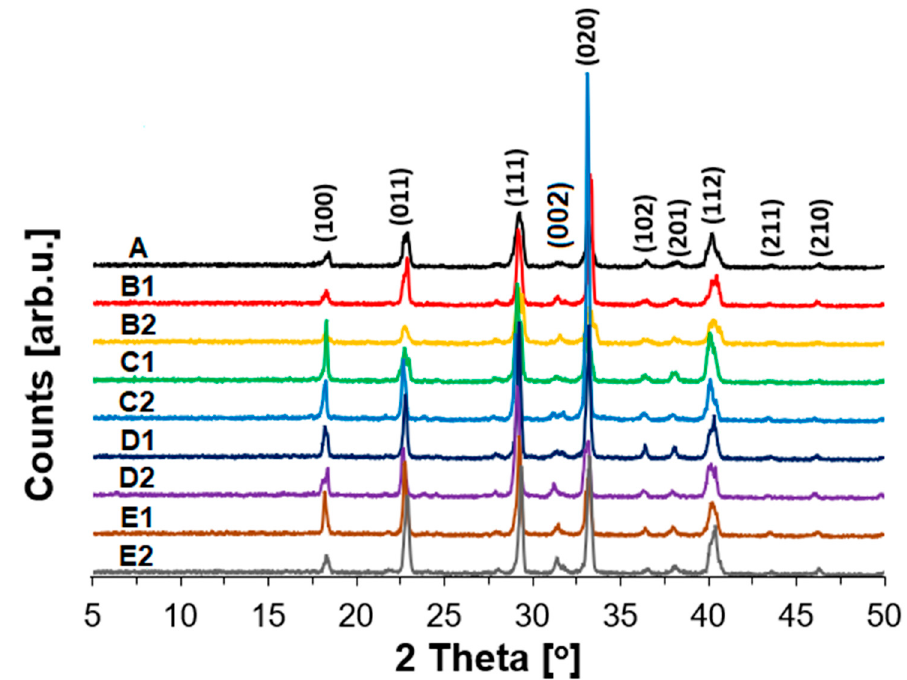
Figure 1. XRD patterns of the studied ANFO samples.